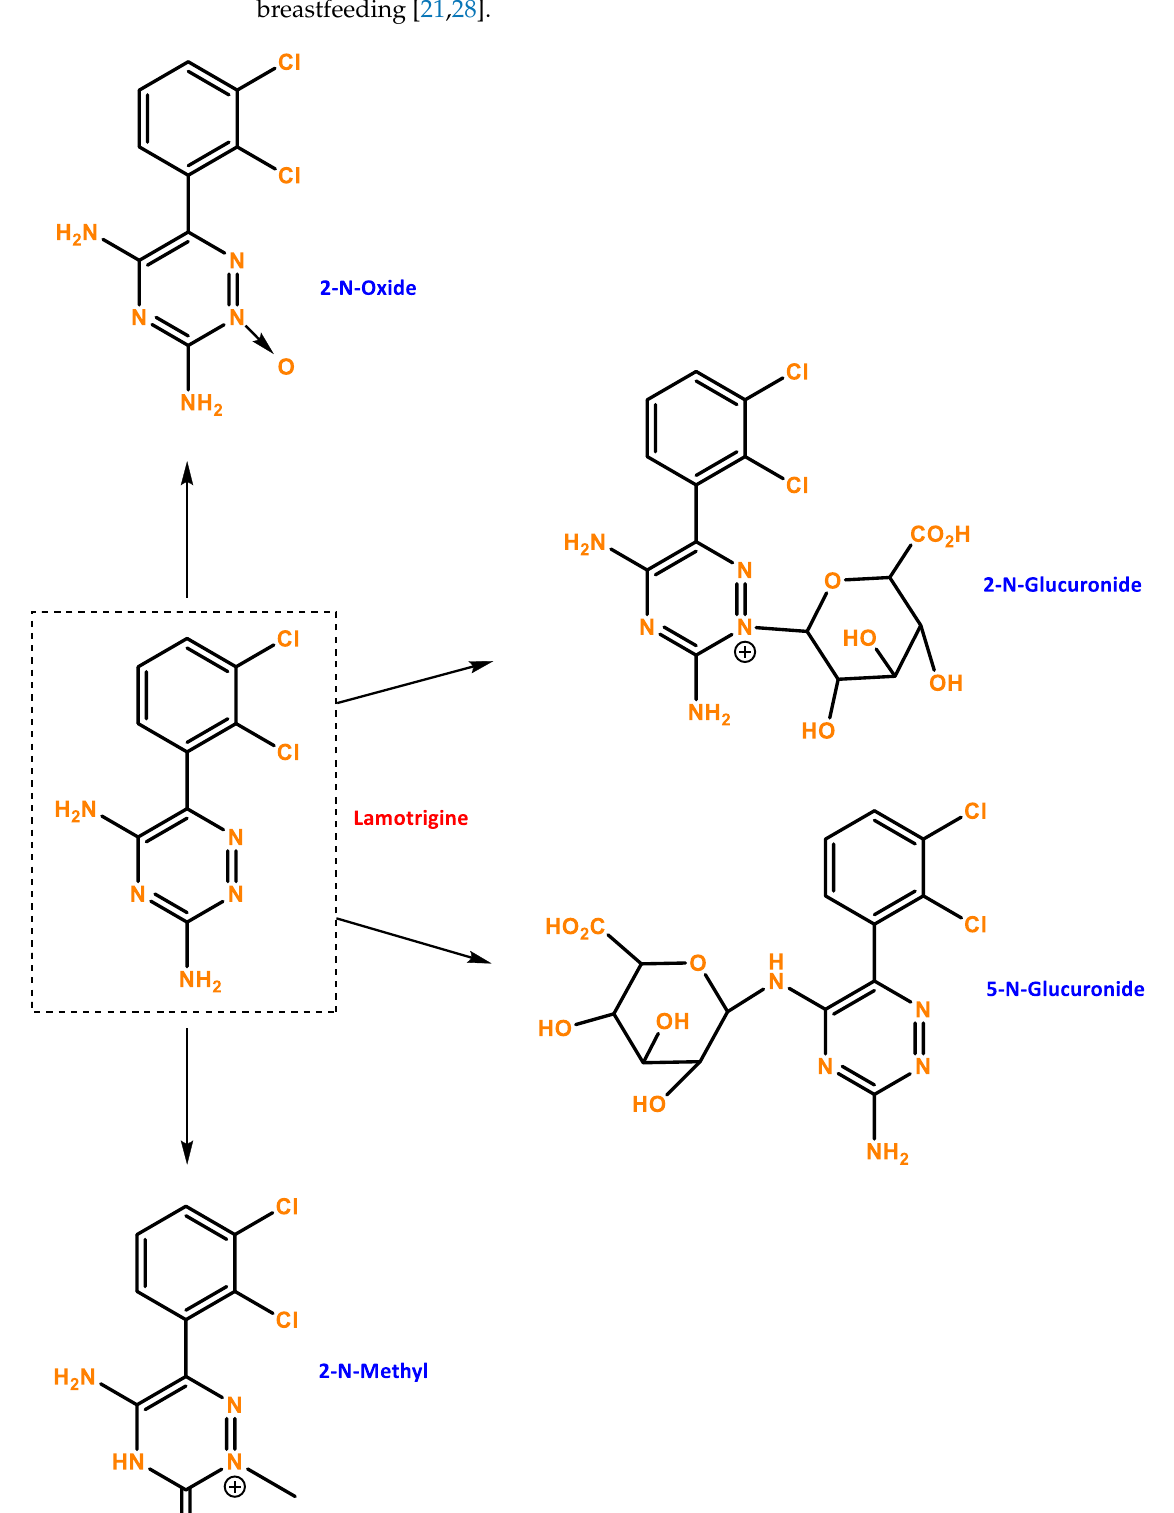
Figure 1. Chemical structure of LTG and possible metabolites. Developed with ChemBioDraw ® Ul- tra 13.0 ChemDraw ® , a chemical drawing